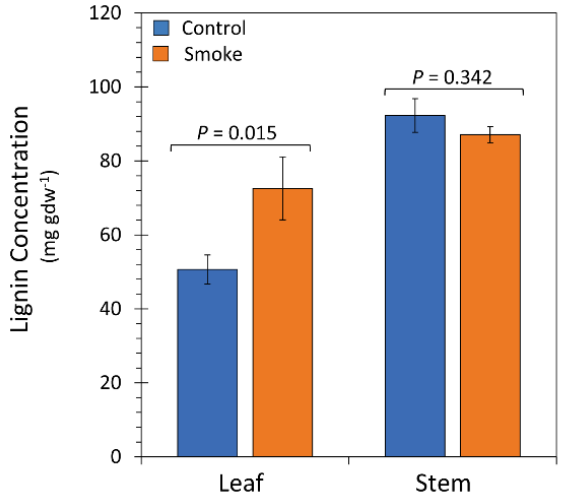
Figure 10. Lignin content. Leaf and stem lignin concentrations are presented in milligrams lignin per gram dry weight of tissue (mg gdw − 1 ). Data bars represent average values ± SE, N = 6 leaves for control and smoke treated, N = 5 stems for control and N = 6 stems for liquid smoke-treated. p -values < 0.05 were considered statistically